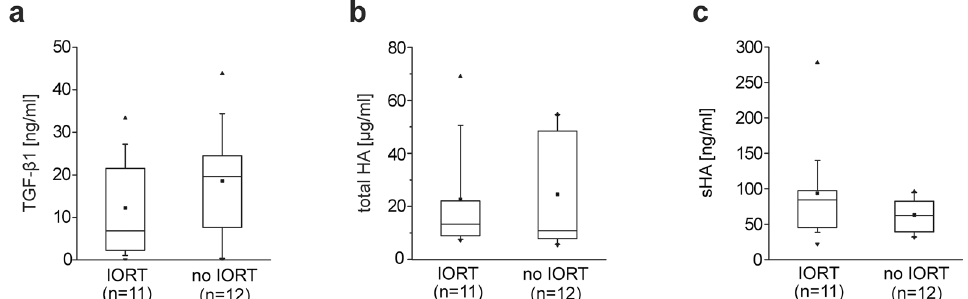
Fig 1. Levels of TGF- β 1, total HA and sHA in wound fluid from breast cancer patients with and without IORT. Box-plots comparing the concentrations of TGF- β 1 ( a ), total HA ( b ) and sHA ( c ) in interstitial fluid draining from breast lumpectomy sites from patients treated with and without IORT. The upper boundary of the boxes indicates the 75 th percentile; the lower boundary indicates the 25 th percentile. The line within the boxes indicates the median and the dot within the boxes represents the mean. Whiskers above and below the boxes indicate the 90 th and 10 th percentile, respectively. The dot lying above the 90 th percentile-whisker represents the maximum and the dot below the 10 th percentile-whisker represents the minimum. Differences between patients with and without IORT were not statistically significant (Kruskal-Wallis test, TGF- β 1 p > 0.18; total HA p > 0.49; sHA p >